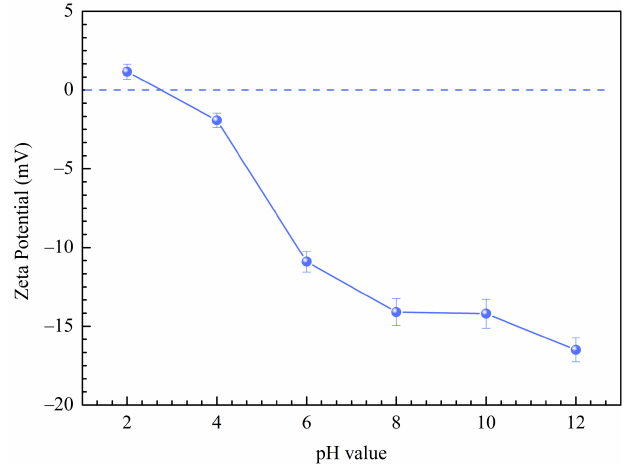
Figure 3. Zeta potentials of RMCRs at different pH.